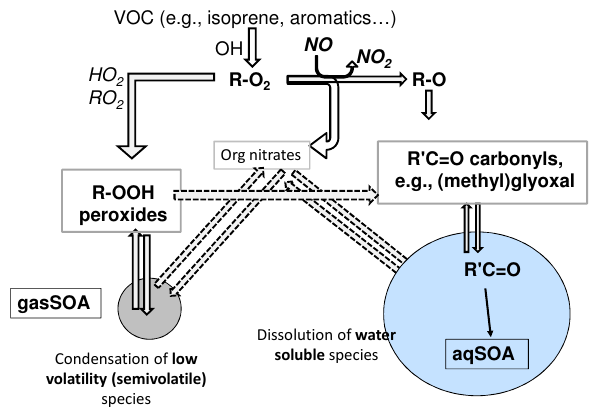
Fig. 5. Fate of peroxy radicals in the gas phase in different NO x scenarios. Dashed arrows depict slow pathways that might only occur on large (spatial, temporal)